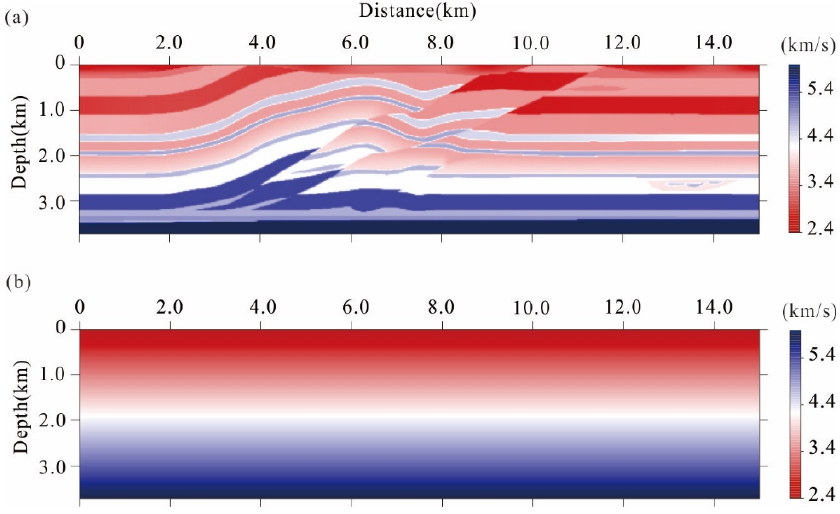
Figure 3. Schematic showing the ( a ) true overthrust velocity model and ( b ) linear velocity initial model.